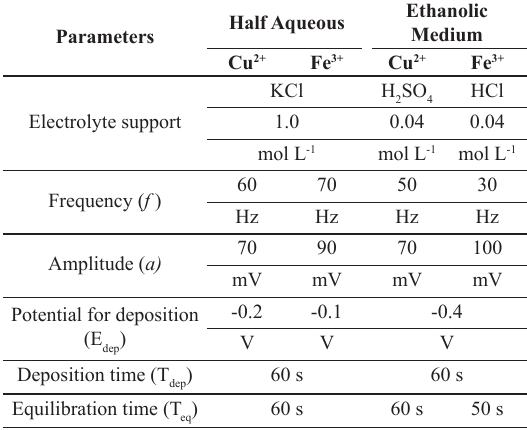
Table 1. Parameters SWASV adopted for the study of Figs of